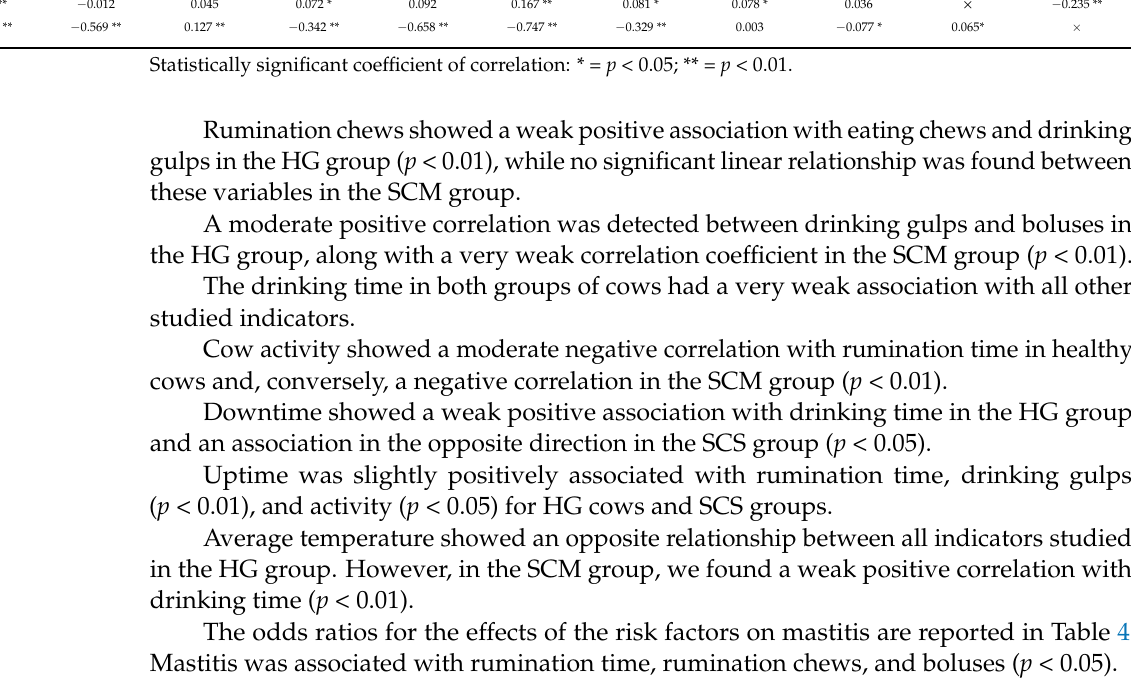
Table 4. Analysis of mastitis risk indicators using a multivariable logistic regression